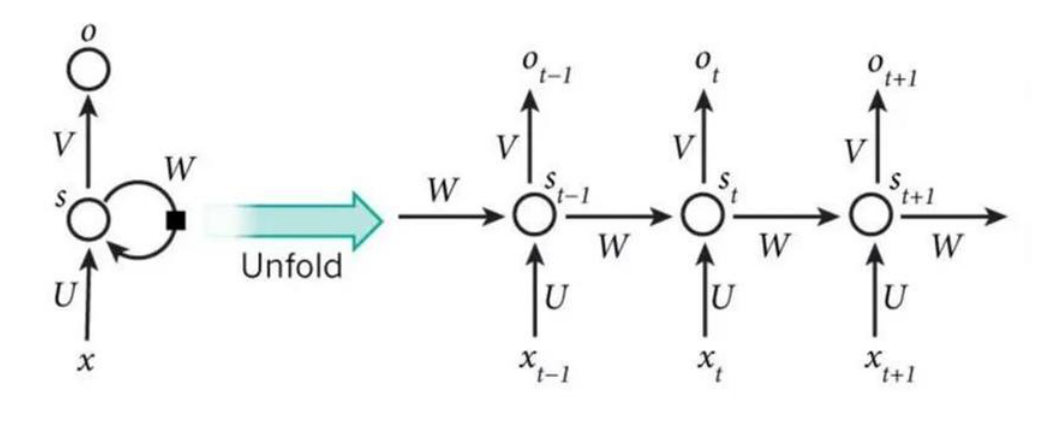
Figure 1. Recurrent Neural Network[5]